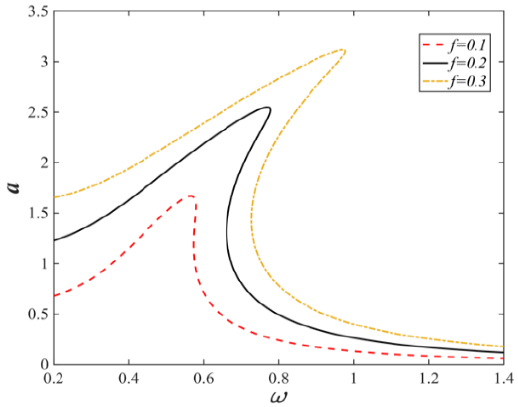
Figure 9. Amplitude and frequency characteristic curves of the system at different f.